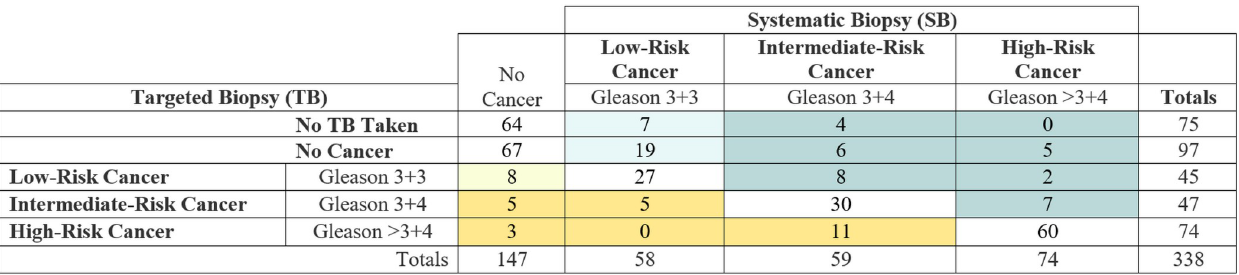
Fig 2. Comparison of biopsy findings from systematic 12-core biopsy and biparametric MRI targeted biopsy (2 cores per lesion, up to 2 lesions per man). Biopsy findings per patient of systematic 12-core biopsy compared with IMPROD biparametric MRI targeted biopsy for the total cohort of 338 men. Yellow shading indicates men in whom targeted biopsy upgraded the PCa risk category in relation to systematic 12-core biopsy. Dark yellow indicates cases in which the upgrade was to an intermediate or high-risk category. Teal shading indicates men in whom systematic 12-core biopsy upgraded PCa risk category in relation to targeted biopsy (or no biopsy based on non-suspicious MRI). Dark teal indicates cases in which the upgrade was to an intermediate or high-risk category.